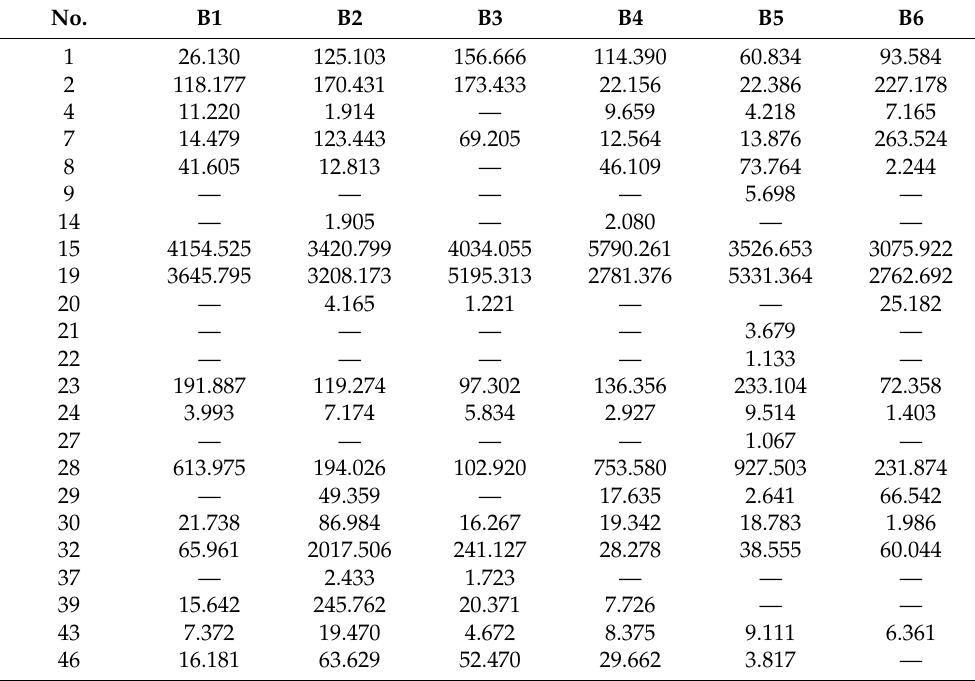
Table 5. Odor activity values (OAVs) of vinegar